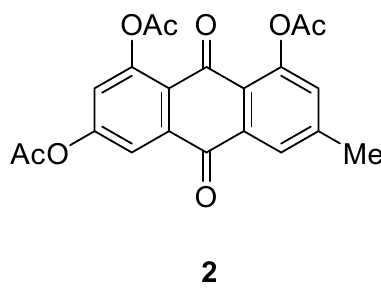
Figure 2. Structure of Compounds 1 and 2.